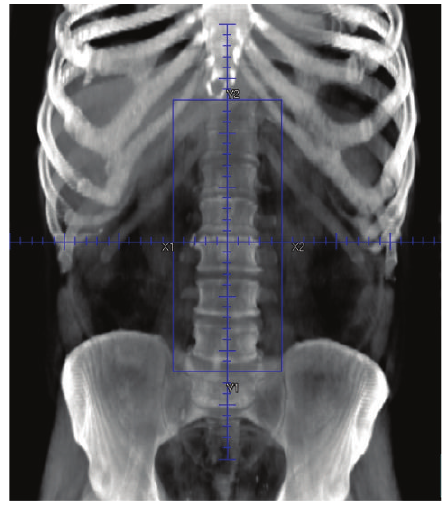
Figure 3: Paraaortic field